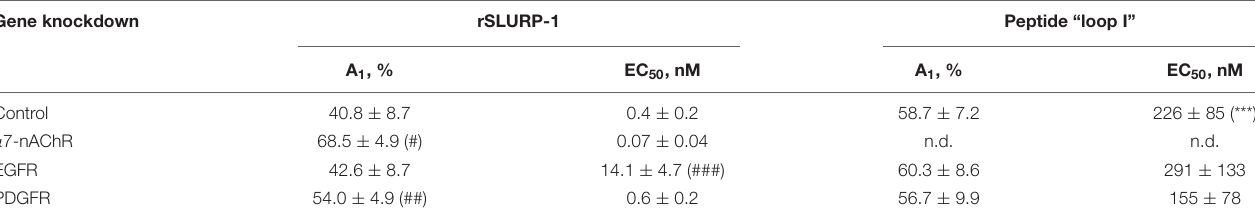
TABLE 1 | Parameters descripting the effect of CHRNA7 , EGFR , and PDGFRA knock-down on the anti-migration activity of rSLURP-1 and synthetic peptide “loop I” in A549 cells a .